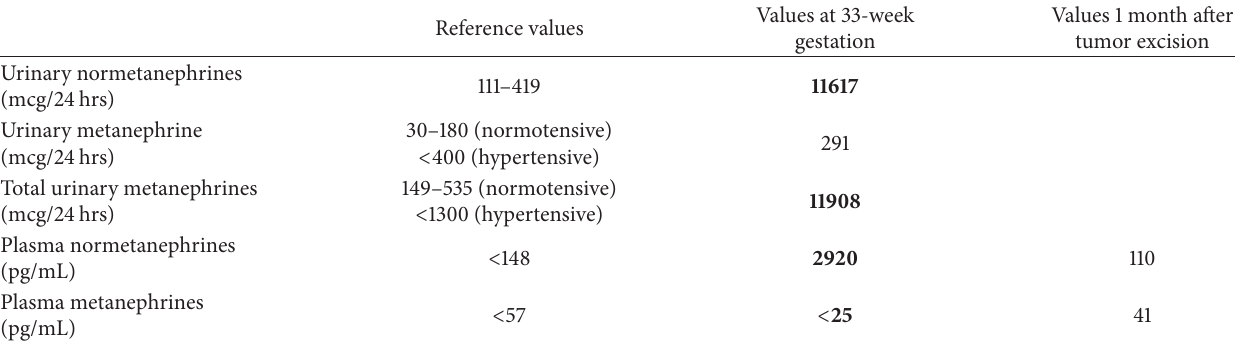
Table 1: The results of free plasma and 24-hour urinary and metanephrines and